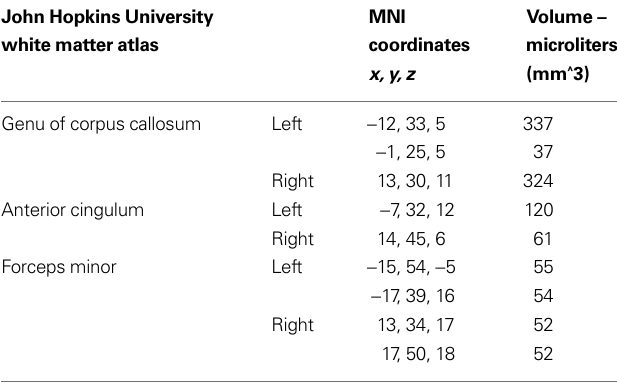
Table 1 | MNI (Montreal Neurological Institute) (Mazziotta et al., 1995) coordinates for regions showing high correlations between monozygotic twin pairs .